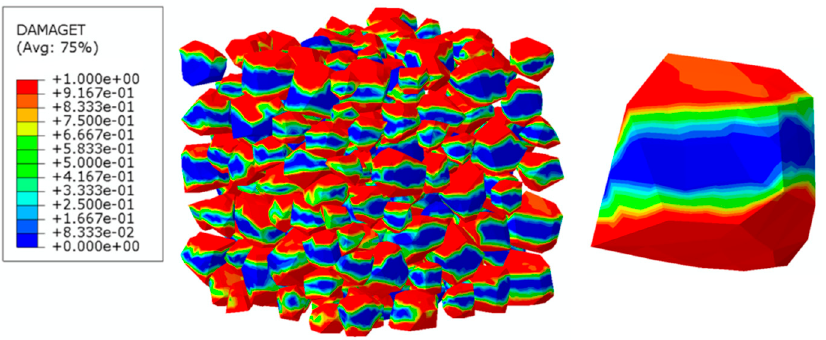
Figure 34. Damage diagrams of ITZ elements at ‘‘g’’ point based on Figure 21b under tension.